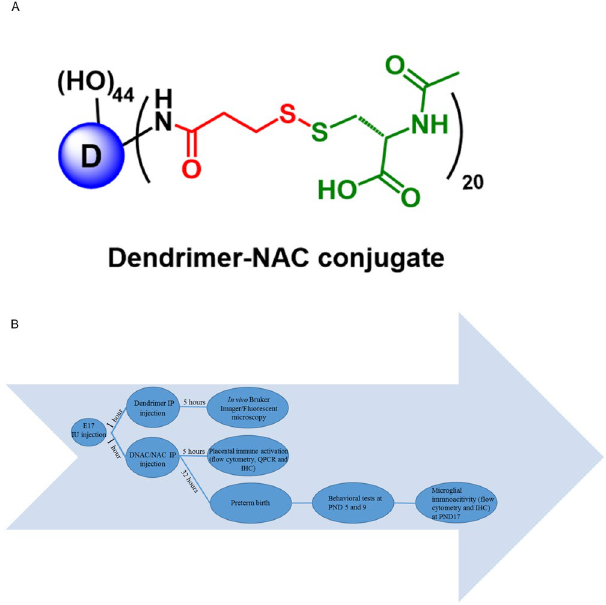
Figure 7. Schematics of dendrimer –NAC and experimental flow. ( A ) Chemical formular of dendrimer- NAC (DNAC). ( B ) Schematic of experimental design. E: embryonic day; IU: intrauterine; IP: intraperitoneal; IHC: immunohistochemistry; PND: postnatal